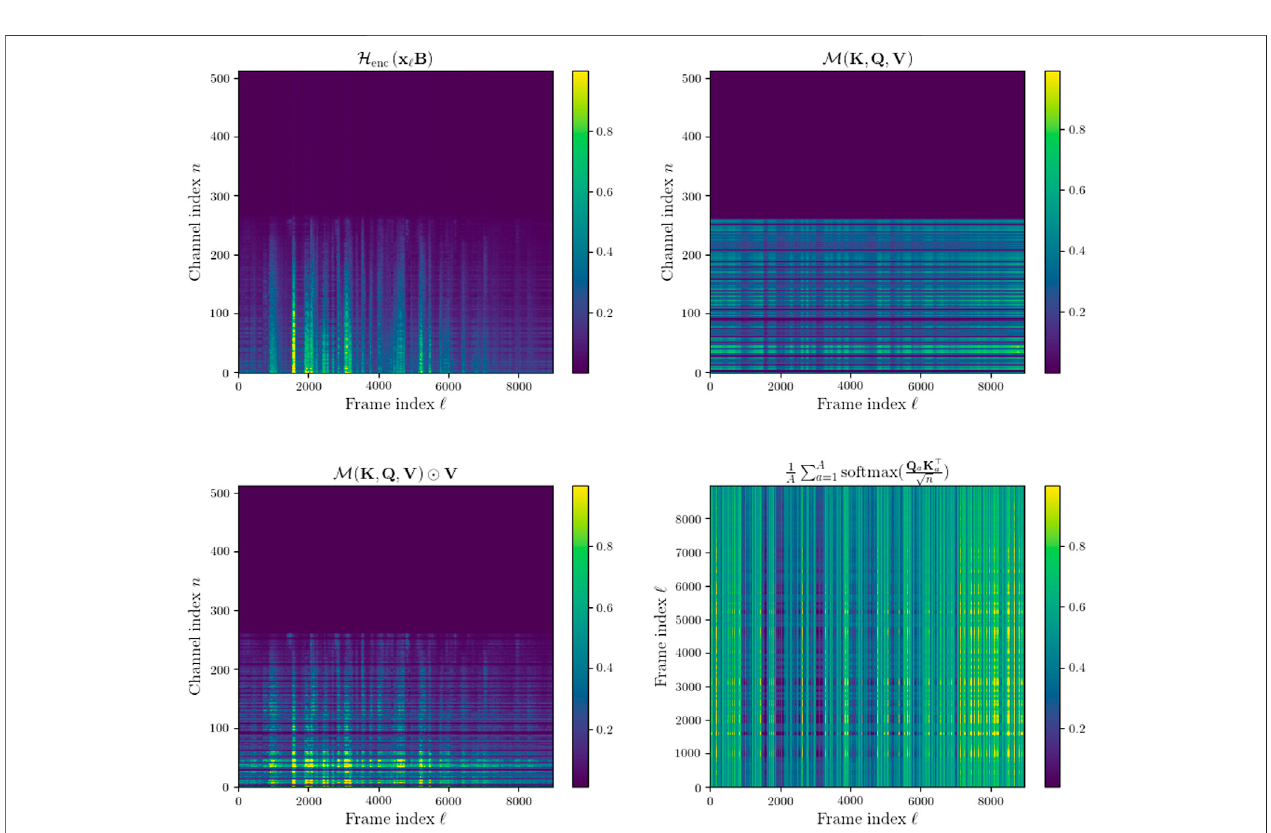
FIGURE 8| Top left: encoded NRSM features after 1D convolution and non-linearity in MHA encoder sorted using Algorithm 1 . Top right: mask-like output ofself attentive MHA layer in MHA. Bottom left: output of the MHA encoder. Bottom right: Averaged attention weight matrix across all attention heads, A =4.